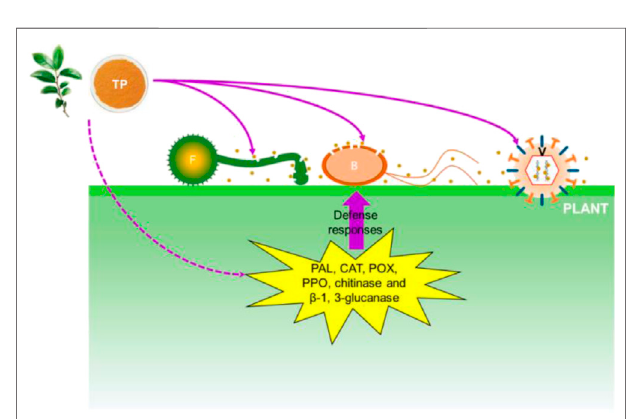
FIGURE 4 | Antibacterial mechanism of polyphenols. Brown dots represent tea polyphenol. TP: tea polyphenol; F: fungi; B: bacteria; V: